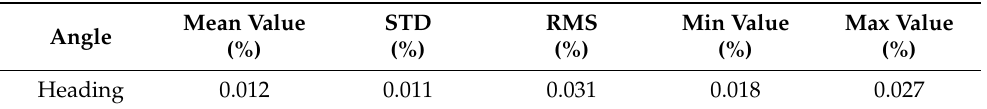
Table 5. Difference between the measured and reference heading angle expressed in relative percent- age terms after Kalman filter